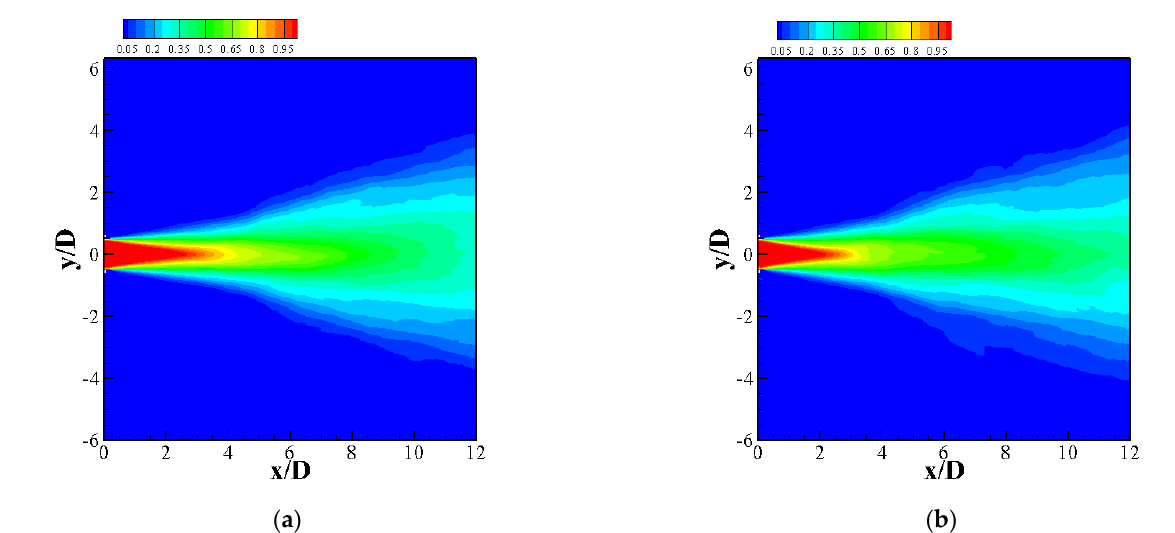
Figure 24. Time-averaged streamwise velocity in the forced plane under different amplitudes. ( a ) MFR = 0.67%, St D = 0.15, ( b ) MFR = 0.83%, St D = 0.05.